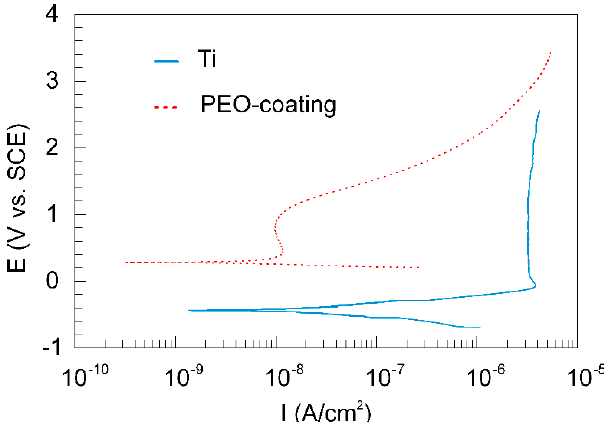
Figure 4. Polarization curves for uncoated sample and sample with a PEO-coating in SBF. Table 4. Corrosion properties of investigated samples in SBF and minimum essential medium